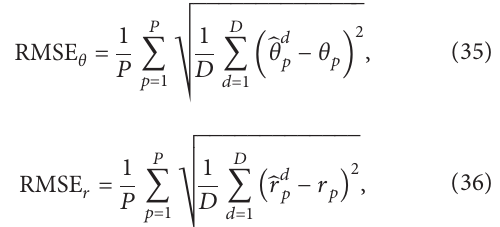
Figure 5: Angle and range estimation results of AP-MLE.